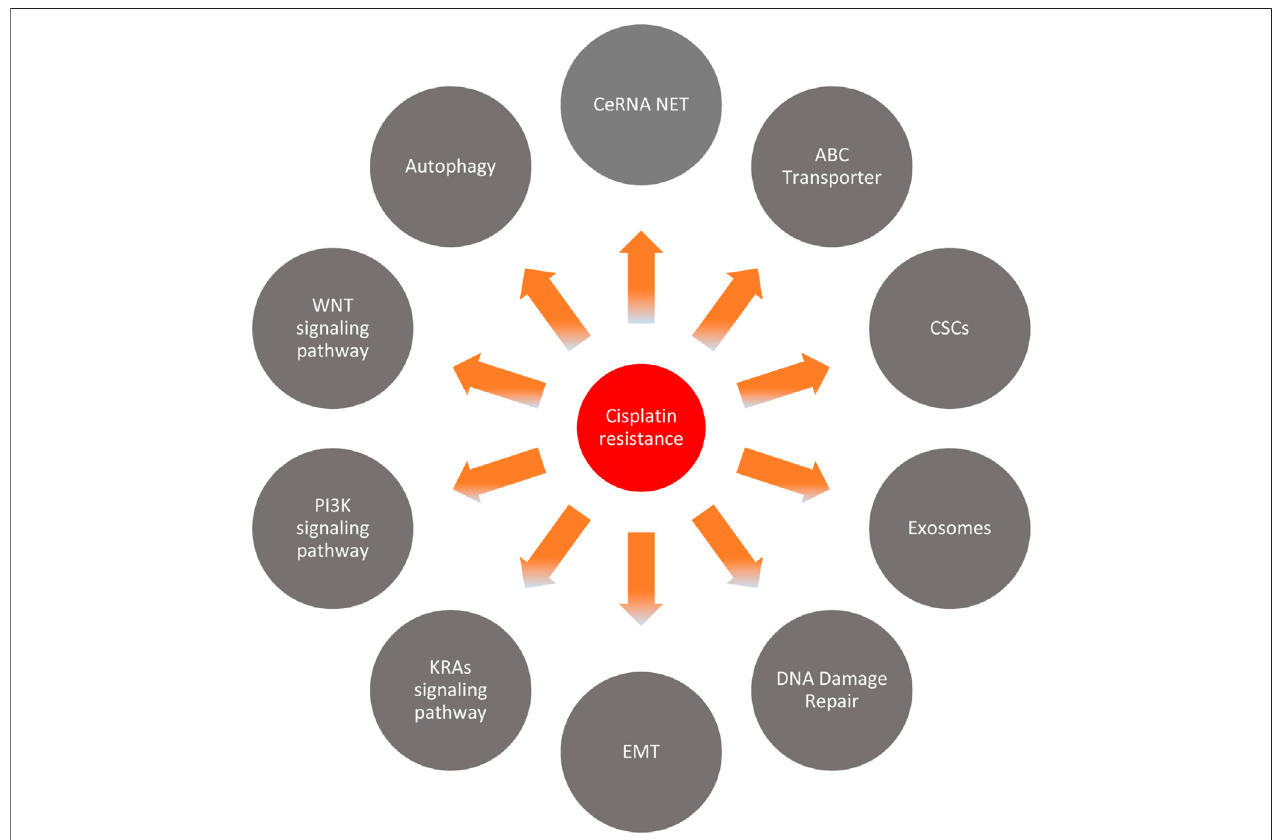
FIGURE 8 | Cisplatin resistance